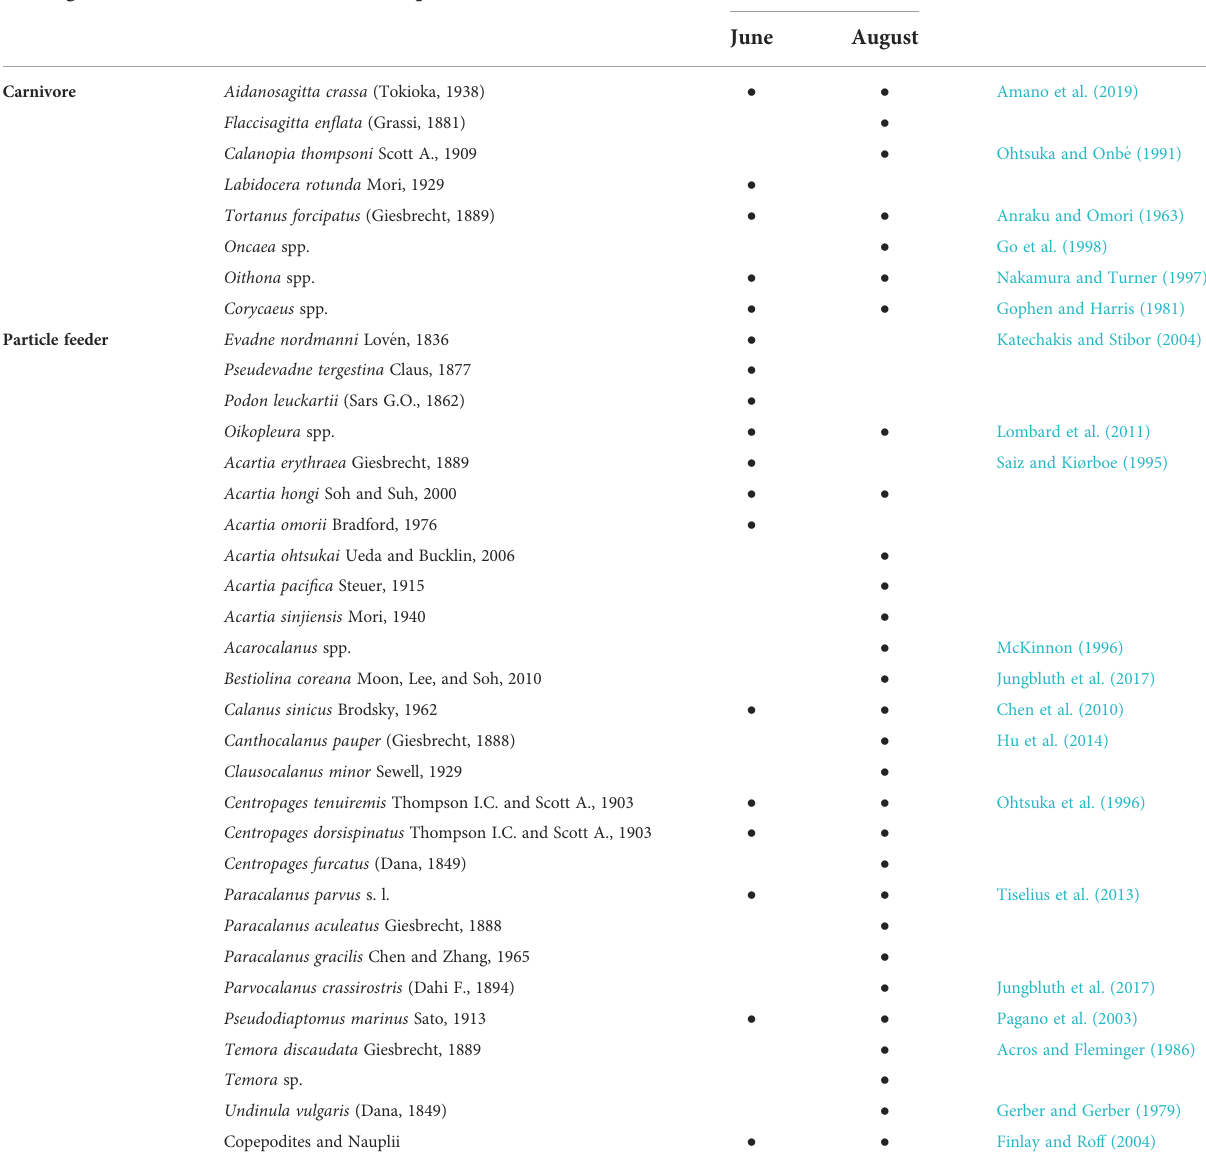
TABLE 1 Observed zooplankton occurrence in Yeosu Bay in June and August according to the feeding habits. Feeding Habits Species Occurrence Reference June